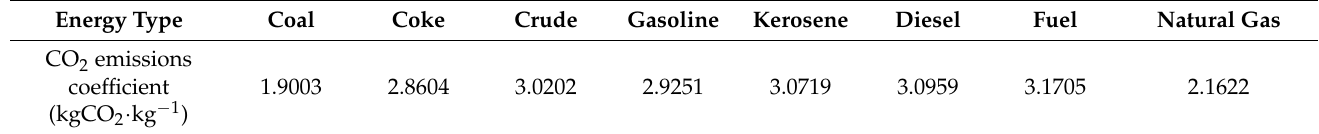
Table 3. CO 2 emission coefficients of various energy sources